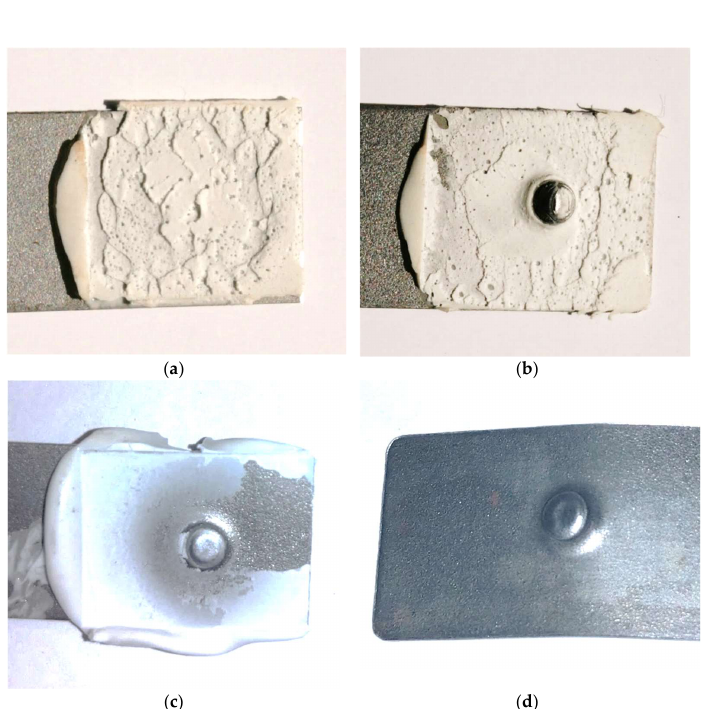
Figure 13. Example view of samples after shear test for: ( a ) first test series, ( b ) second test series, ( c ) third test series, and ( d ) fourth test series. Table 8. Shear force obtained during strength tests (the complete set of results are available in the Appendix A, Table A4).